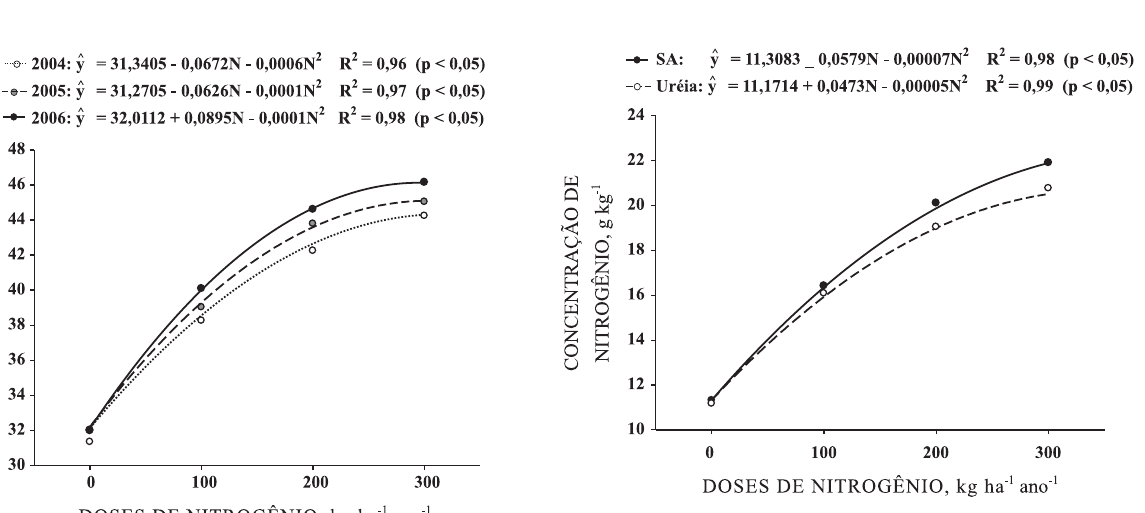
Figura 2. Concentração de nitrogênio nas lâminas de folhas recém-expandidas do capim-marandu, em função de doses de nitrogênio aplicadas na forma de sulfato de amônio e de uréia (média de três cortes